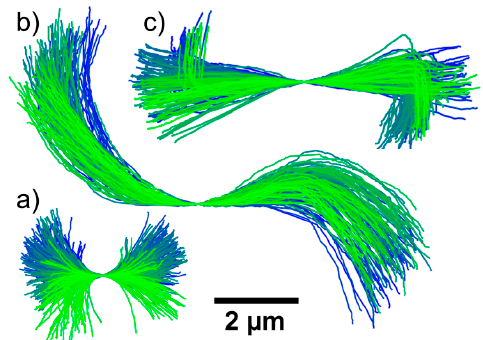
Figure 4. ( a – c ) Temporal evolution of the 2D projections of the microgel chains shown in the fluorescence microscopy images in Figure 3. For a clearer representation, the centers of the chains were positioned in the same points and the 2D projections of the chains were rotated in-plane so that the slope in this point equals zero. The color variation from blue to green represents the evolution over the frame sequence.